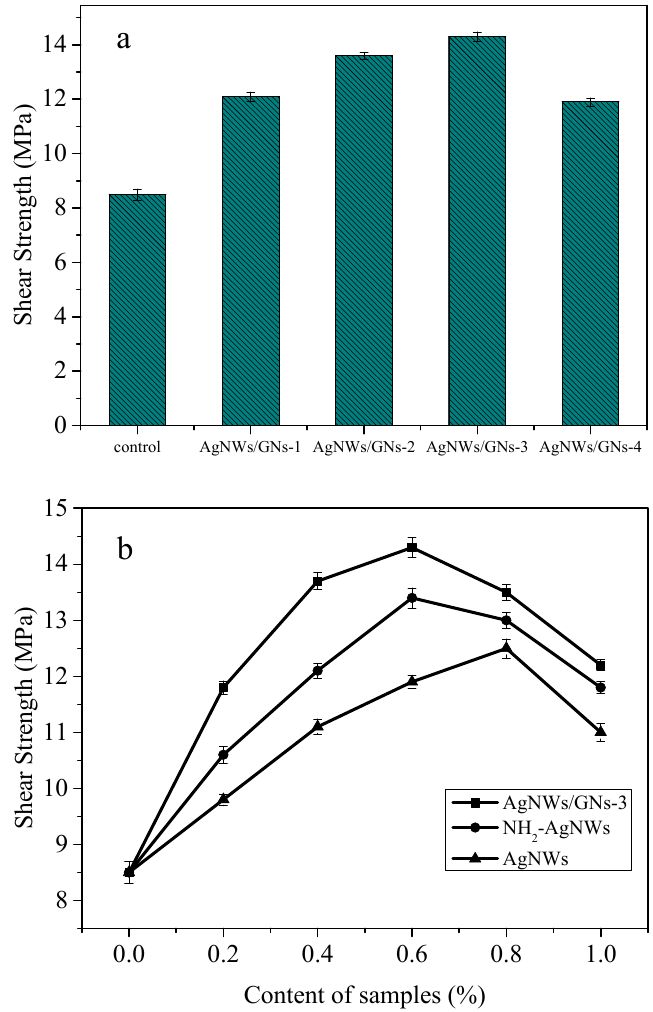
Figure 9. Shear strength of the ECAs filled with the nanocomposites with different proportions of AgNWs to GO ( a ) and different contents of the samples ( b ).